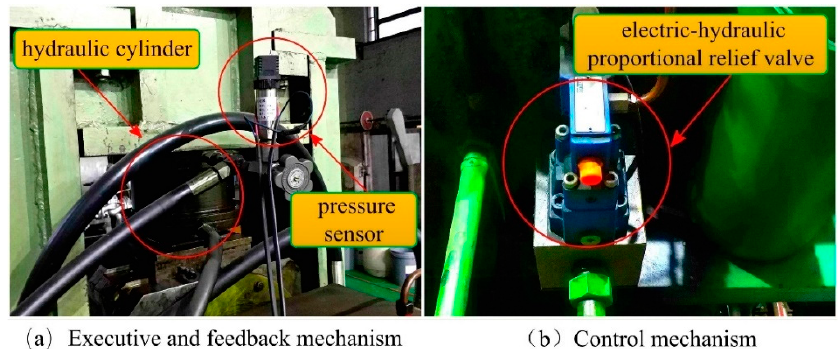
Figure 9. Main mechanism of Journal bearing test rig.